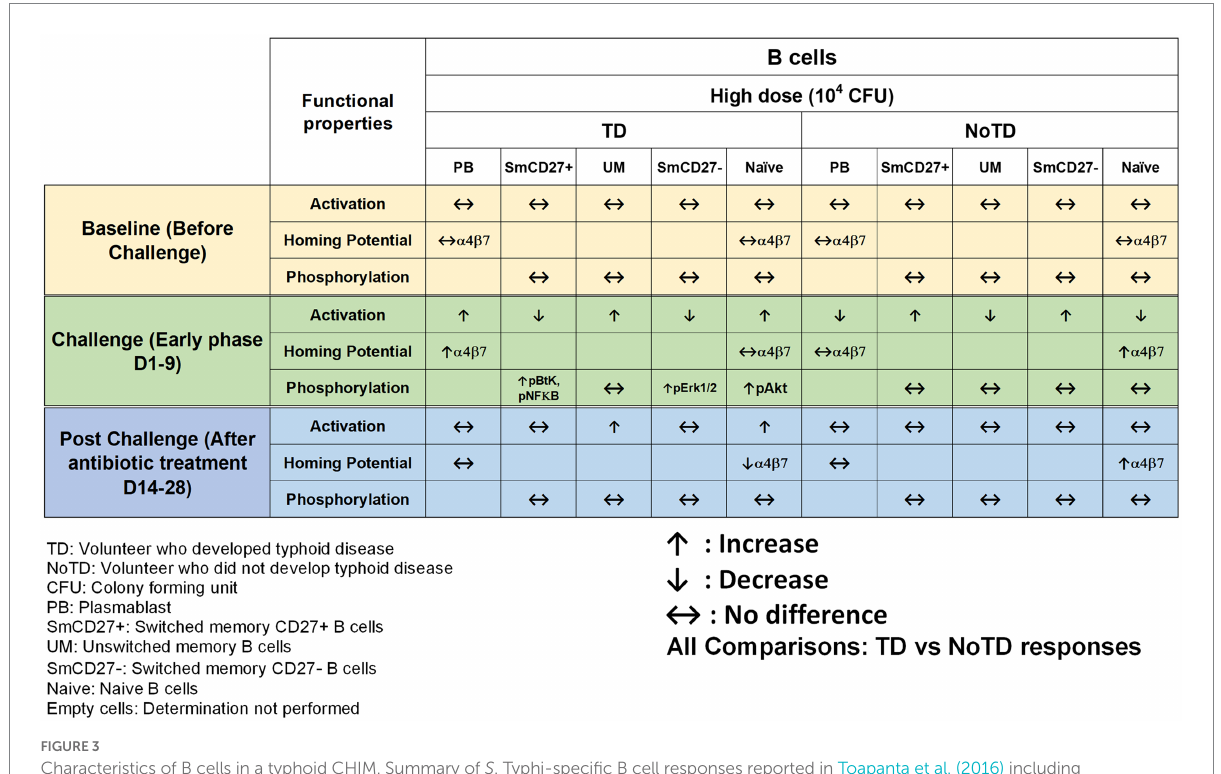
FIGURE 3 Characteristics of B cells in a typhoid CHIM. Summary of S . Typhi-specific B cell responses reported in Toapanta et al. (2016) including comparisons between TD and NoTD at baseline (before challenge), early days after challenge (D1-9) and at later time points after challenge (D14-28). ↑ : Increase; ↓ : Decrease; ↔ : No